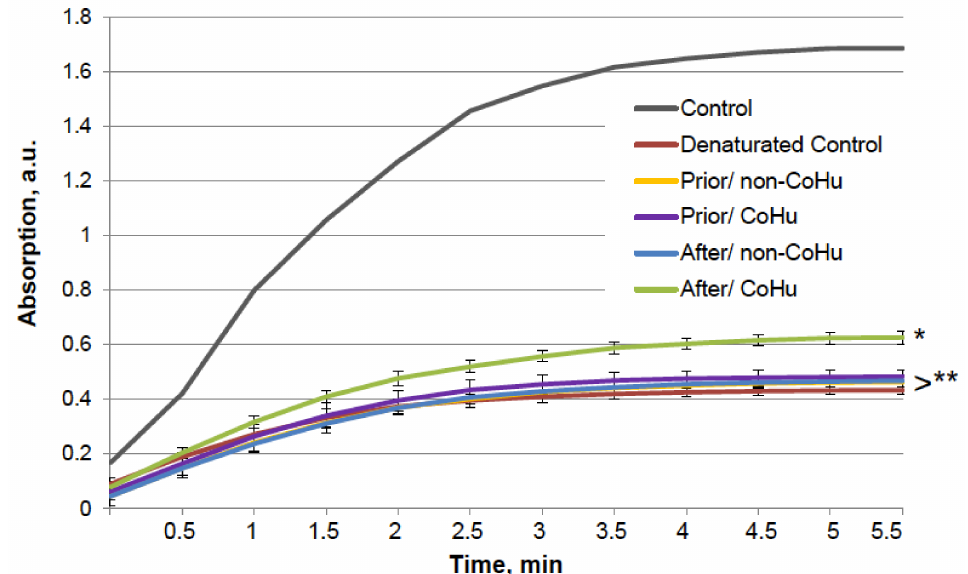
Figure 9. Effect of CoHu on denatured alkaline phosphatase activity. Data presented as mean arbitrary units ± SD. Control—activity of an intact enzyme not exposed to unfolding buffer. Prior/non-CoHu— activity in samples that were treated with non-CoHu before inactivation. After/CoHu—activity in samples that were treated with CoHu after inactivation. Prior/CoHu—activity in samples that were treated with CoHu before inactivation. * and **—Lines with different superscripts differ significantly ( p <